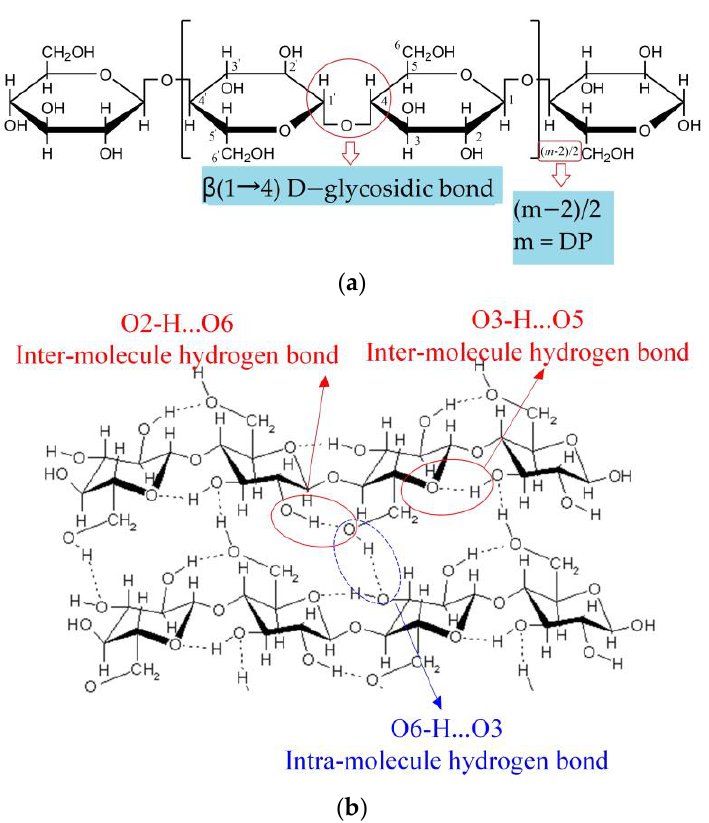
Figure 8. ( a ) Repetitive unit of cellulose. ( b ) Inter- and intra-molecule hydrogen bond structure of cellulose.